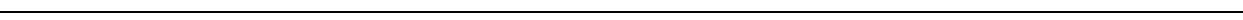
Fig. 3 Neuronal characterization of different subpopulations activated in the discriminator rats following a new tone or CS presentation within the LA. a Representative photomicrograph of triple catFISH showing neurons expressing H1a (green arrows), Arc (red), and CamKIIa (white) mRNAs. The merged panel shows nuclei that were single-, double- or triple-labeled for H1a , Arc , and CamKIIa . Scale bar, 20 µ m. b Dot-plots graphs showing the percentage of cells coexpressing either H1a (new tone) or Arc (CS) or H1a + Arc (new tone + CS) with CamKIIa . c Images of triple catFISH showing expression of H1a , Arc , and Thy-1 mRNAs. d The percentages of cells coexpressing Thy-1 and either H1a or Arc or those coexpressing H1a + Arc were low and similar among the three conditions. e Images showing the expression of Arc , H1a , and Grp mRNAs. f The percentages of cells coexpressing Grp and either H1a or Arc or both mRNAs were high and similar among the three conditions. g Photomicrographs showing neuronal expression of H1a , Arc , and Parvalbumin ( PV ) mRNAs. h The percentages of cells coexpressing PV were similar in neurons that were activated following the presentation of the new tone or the CS. i Images showing triple catFISH for Arc , H1a , and Somatostatin ( SOM ) mRNAs. j The percentages of cells coexpressing SOM with Arc , H1a , or H1a + Arc were similar following the presentation of the new tone or the CS. k Images of triple catFISH showing the mRNA expression of H1a , Arc , and Calretinin (CR) . l There were no differences in the percentages of cells coexpressing CR with H1a , Arc , or H1a + Arc . m Pie charts summarizing the percentages of cells in different subpopulations of neurons that were activated by the new tone, CS or both, according to the expression of different neuronal markers. All data are mean and